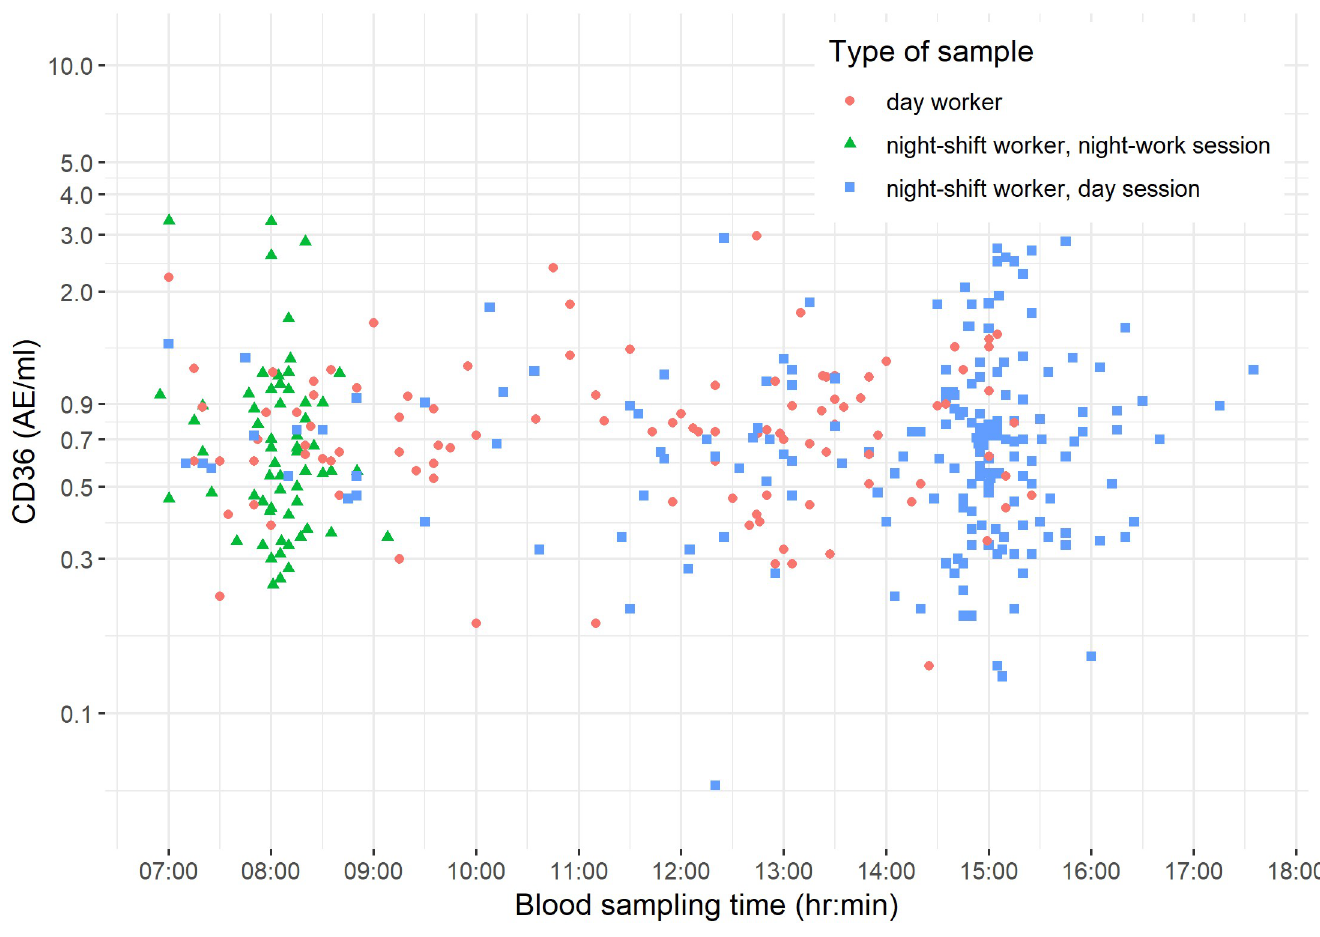
Fig 1. Log-transformed sCD36 levels in blood versus sampling times for night-shift workers during a night-shift session, night-shift workers during a day-shift session, and day workers during a day-shift session (n = 293 observations and 230 individuals).